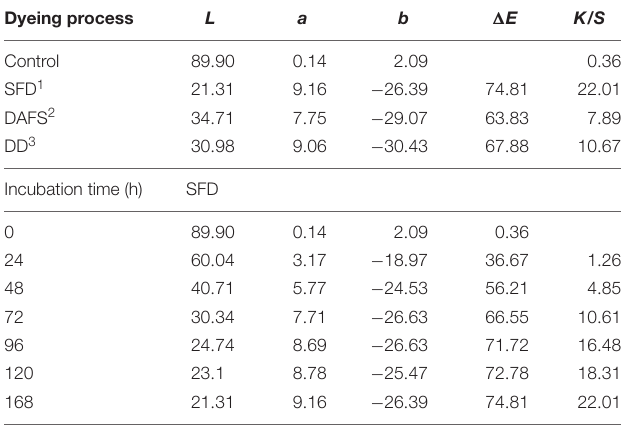
TABLE 1 | Color coordinates of fabrics dyed via SFD, DAFS, and DD